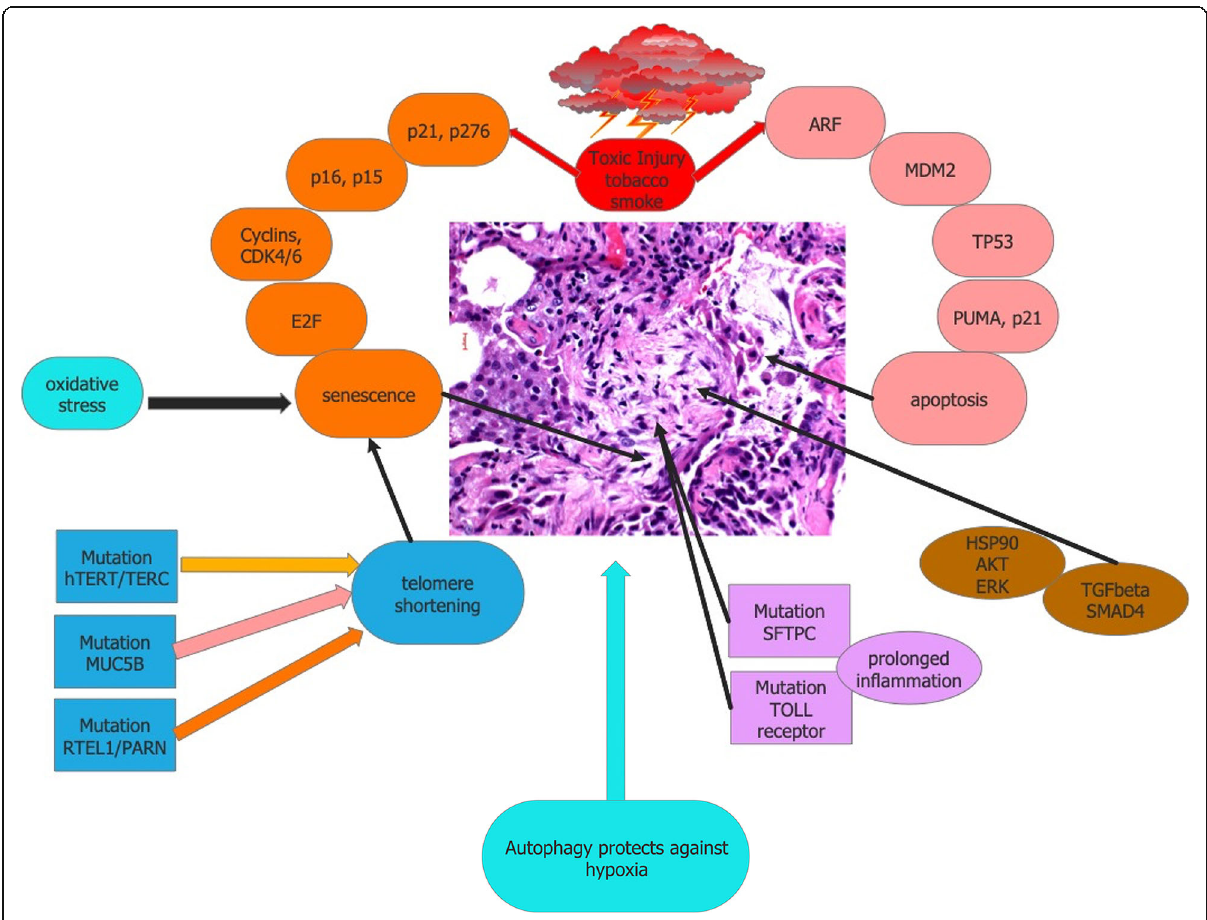
Fig. 10 Schematic diagram of the development of UIP/IPF. In familial and sporadic IPF an underlying gene defect induces apoptosis of pneumocytes, but in addition, some cells undergo senescence (in Fig. 7 these cells highlighted by p16 and p21 stains). Senescent cells release cytokines and growth factors, which induce proliferation of myofibroblasts. Later on, these cells undergo differentiation, become fibroblasts and turn immature collagen-III into mature collagen-I. There are still open questions, such as how much EMT and MET contributes to the continuation of the myofibroblast proliferation, what is the role of bone marrow derived stem cells? In chronic autoimmune and allergic diseases the causing factors are autoimmune mechanisms, deregulation of the immune system, by which probably cytotoxic lymphocytes induce apoptosis and necrosis of pneumocytes, followed by the same downstream inflammatory mechanisms, leading to fibrosis. Mutations of telomerase genes contribute to the senescence process, mutations in surfactant apoprotein genes and MUC5B might be involved in prolongation of the inflammatory status. Heat shock proteins seem to be involved in maintaining the myofibroblast proliferation